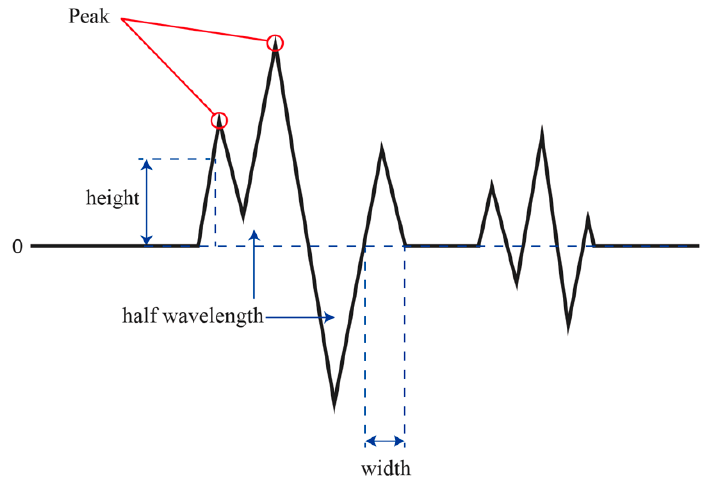
Figure 6. Example of a music wave data section.